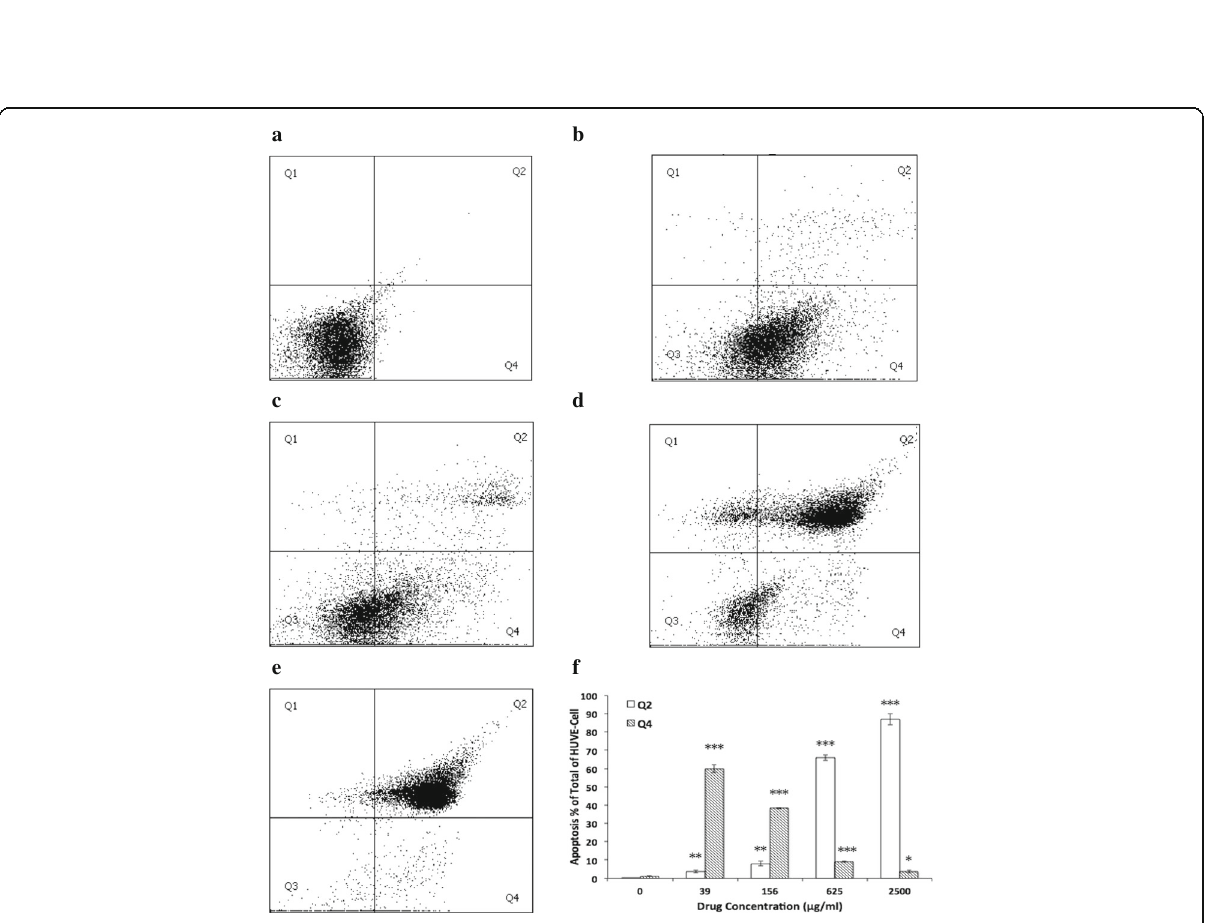
Fig. 2 Effect of oridonin on HUVEC apoptosis. HUVECs were treated with various concentrations (39 – 2500 μ g/ml) of oridonin, and apoptosis was determined by FAC assay for 24 h. a control group; b 39 μ g/ml oridonin group; c 156 μ g/ml oridonin group; d 625 μ g/ml oridonin group; e 2500 μ g/ml oridonin group; f HUVEC apoptosis for Q2 and Q4 comparison. The asterisks indicate statistically significant differences for oridonin groups compared with the control group (* P < 0.05, ** P < 0.01, *** P <